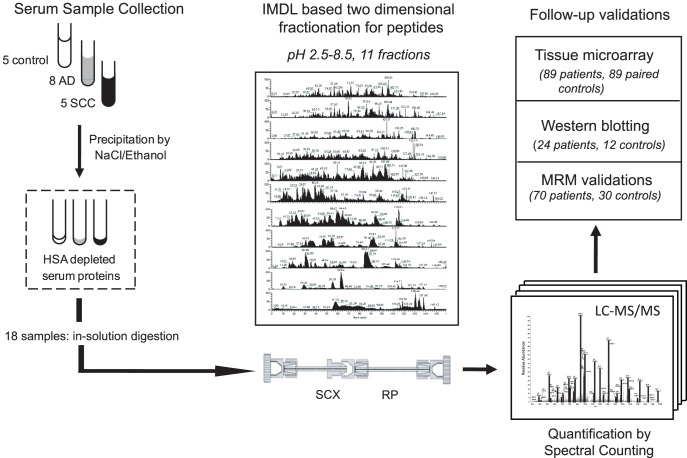
Experimental schema of the discovery and verification phases.Left panel, serum samples collection and depletion to remove the human serum albumin (HSA); Middle panel, IMDL fractionation which separates serum peptides by their pIs (2.5∼8.5) and hydrophobicity, with an example of HPLC-MS/MS chromatography showed for each pH step elution; Right panel, the number of NSCLC patients and the number of age-matched healthy controls in the verification phase by western blotting, TMA and MRM measurement. SCX, strong cation exchanger, RP reversed-phase chromatography. AD: Adenocarcinoma; SCC: Squamous cell carcinoma; NSCLC: Non-small cell lung cancer.